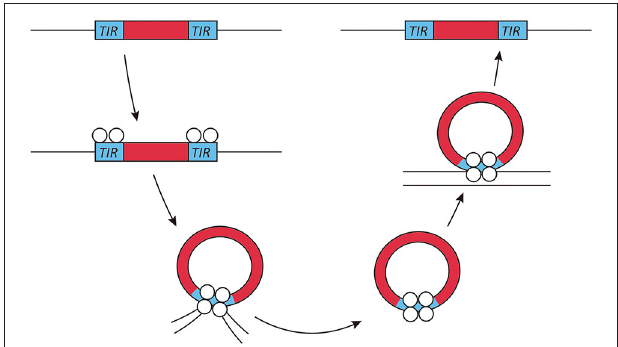
FIGURE 1 | Transposon mechanism of class II DNA transposons. Class II or DNA transposons are first excised from the genome by a transposase. The terminal inverted repeats (TIRs) play an essential role in this process, as they probably lead to the temporary formation of a circular DNA fragment, which then reinserts into a different genomic location. This genome integration is probably helped by the integrase activity of the